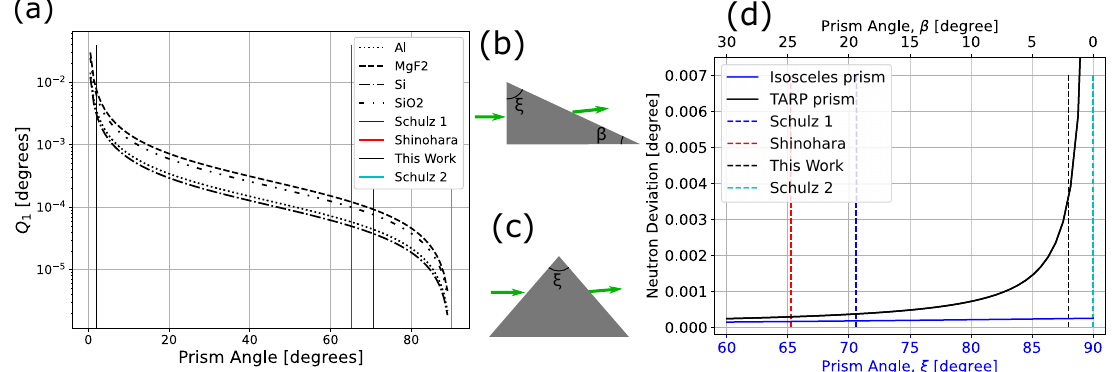
Figure 5. ( a ) Quality-factor, Q 1 , for a neutron prism, calculated using beam deviation and neutron transmission fraction, Q 1 = ∆ θ · T , as a function of prism angle. Here, it is clear that smaller prism angles provide a significant increase in prism quality-factor. Note that this plot is shown in logarithmic y-scale. Different materials are considered, and as black lines of different style (i.e., dotted, dashed). Prism angles utilized in other neutron prism experiments are shown in solid lines, with the TARP shown in black, the prisms of the Ref. [49] shown in red, and both prisms described in the Ref. [48] shown in dark and light blue. ( b ) Schematic of prism orientation used in the TARP device, with both the prism angle β and complementary angle, ξ , labelled. ( c ) Schematic of prism orientation used in the Ref. [48,49] with prism angle, ξ , and neutron ray shown as a green arrow. ( d ) Comparison of neutron deviation from prism orientations shown in ( b , c ) plotted in blue and black,